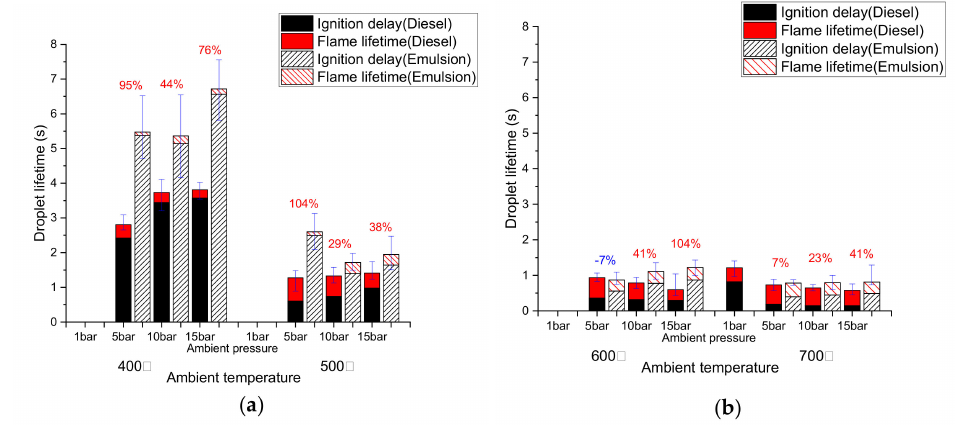
Figure 15. Total diesel and emulsion droplet lifetime ( a ) below 500 ◦ C and ( b ) above 600 ◦